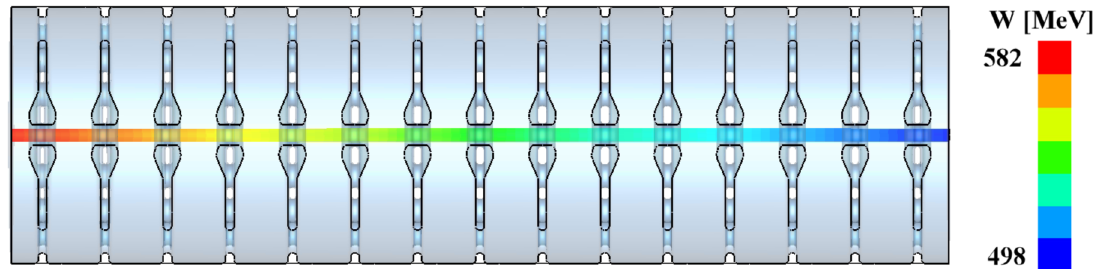
FIG. 13. Energy gain (in color) of 45 MeV = u 12 C 6 þ beam at − 20 degrees synchronous phase in 15 cells section of β ¼ 0 . 3 NHS as simulated in CST P ARTICLE S